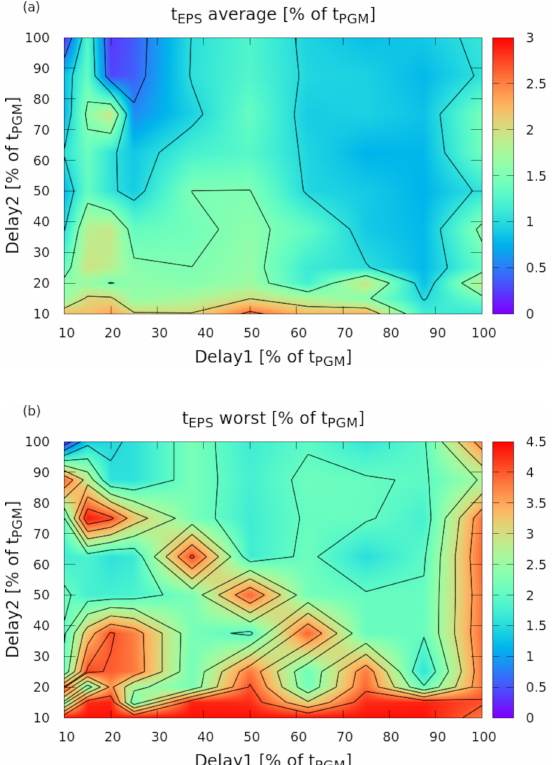
Figure 7. ( a ) The average of the t EPS measurements performed on 50 randomly sampled wordlines in a 3D NAND Flash block. ( b ) The worst t EPS in each